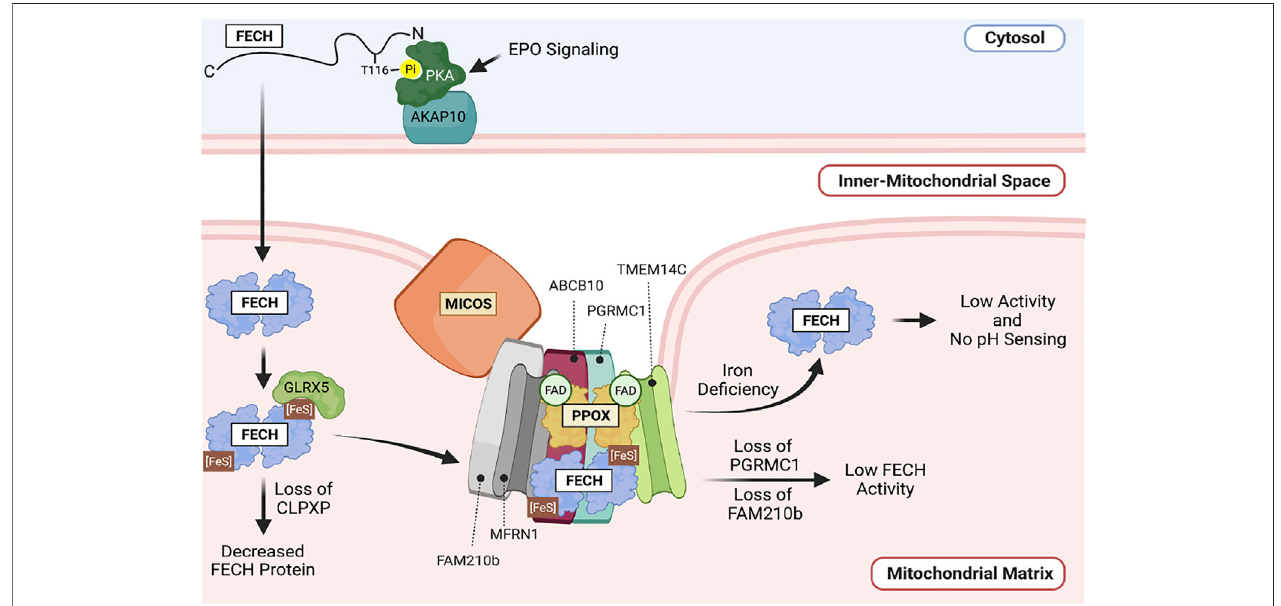
FIGURE4| RegulationofFECHinthemitochondria.FECHistightlyregulatedbypost-translationalmodi fi cationsandFe-Sbinding.FECHisphosphorylatedonthe outer mitochondrial membrane. This isregulated by EPO signaling. Within the mitochondrial matrix, FECH activity is regulated by pH, Fe-S binding, the CLPXP complex as well as binding to other proteins in a macromolecular complex such as MFRN1, PPOX, the MICOS complex and FAM210B.